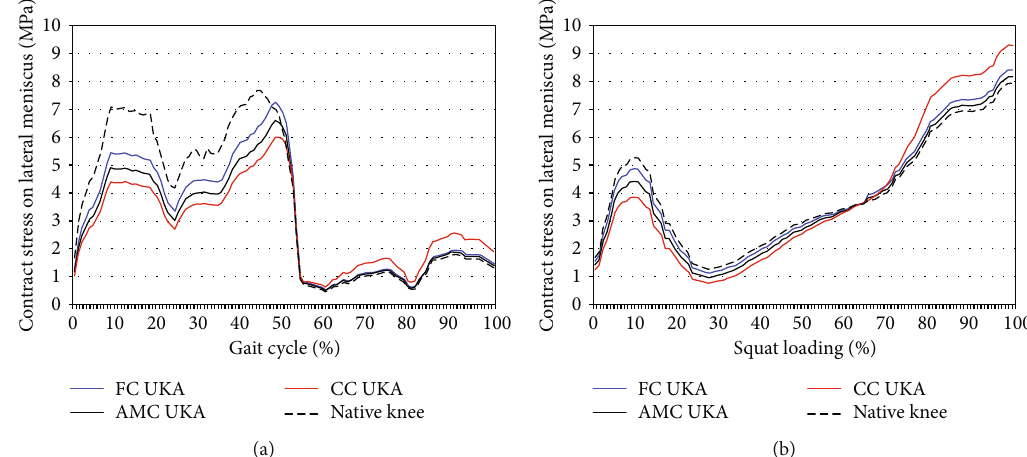
Figure 5: Comparison of the contact stress on the lateral meniscus in three customized UKA designs with three di ff erent conformities against that on a native knee under (a) gait and (b) squat loading conditions.